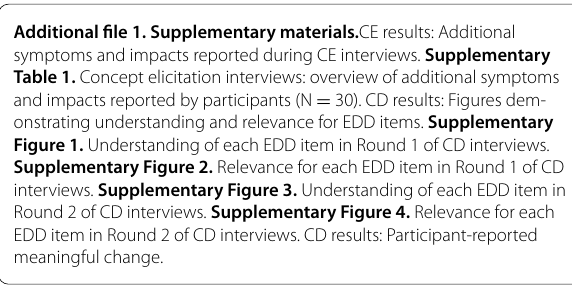
Table 1. Concept elicitation interviews: overview of additional symptoms and impacts reported by participants (N 30). CD results: Figures dem- = onstrating understanding and relevance for EDD items. Supplementary Figure 1. Understanding of each EDD item in Round 1 of CD interviews. Supplementary Figure 2. Relevance for each EDD item in Round 1 of CD interviews. Supplementary Figure 3. Understanding of each EDD item in Round 2 of CD interviews. Supplementary Figure 4. Relevance for each EDD item in Round 2 of CD interviews. CD results: Participant-reported meaningful